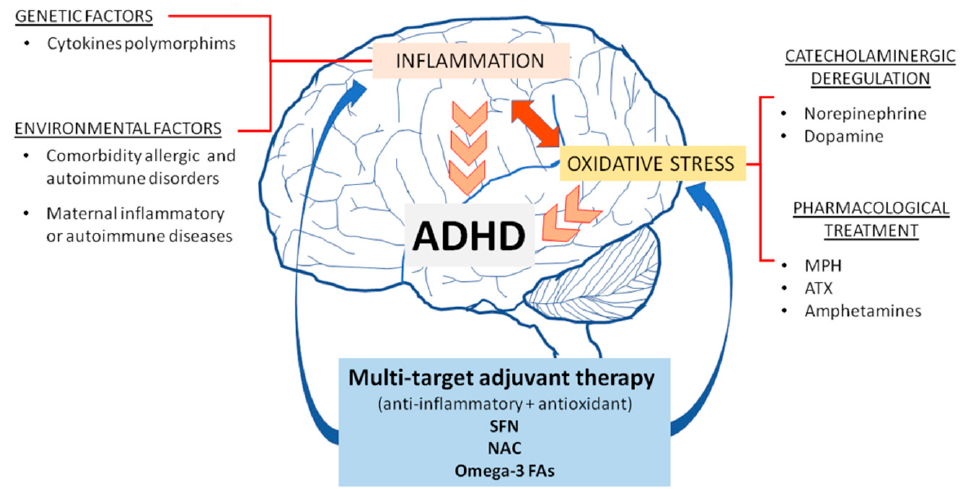
Figure 1. Role of inflammation and oxidative stress in the pathophysiology of ADHD and potential adjuvant therapy. Environmental and genetic factors, catecholaminergic dysregulation and pharmacological treatment can establish a vicious circle, producing inflammation and oxidative stress, therefore contributing to increase the symptoms. SFN, sulforaphane; NAC, N-Acetylcysteine; omega-3 FAs, omega-3 fatty acids; MPH, methylphenidate; ATX, atomoxetine.